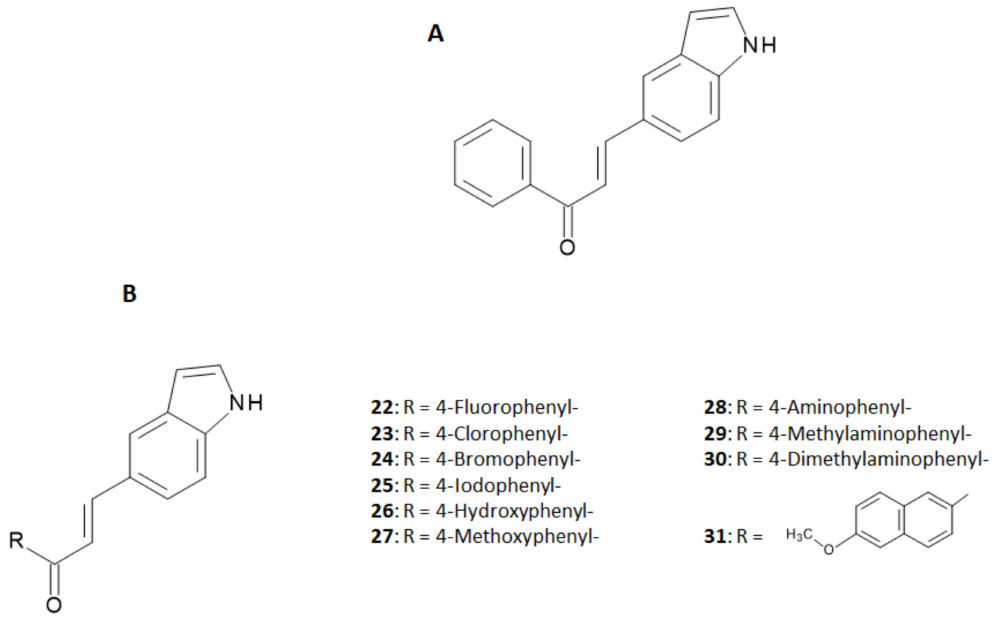
Figure 9. General structure of an indole-chalcone ( A ). Indole-Chalcone derivatives studied by Cui et al. [31] ( B ). Table 4. Inhibition constants of indole-chalcone derivatives against [ 125 I] IMPY as adapted from [31].